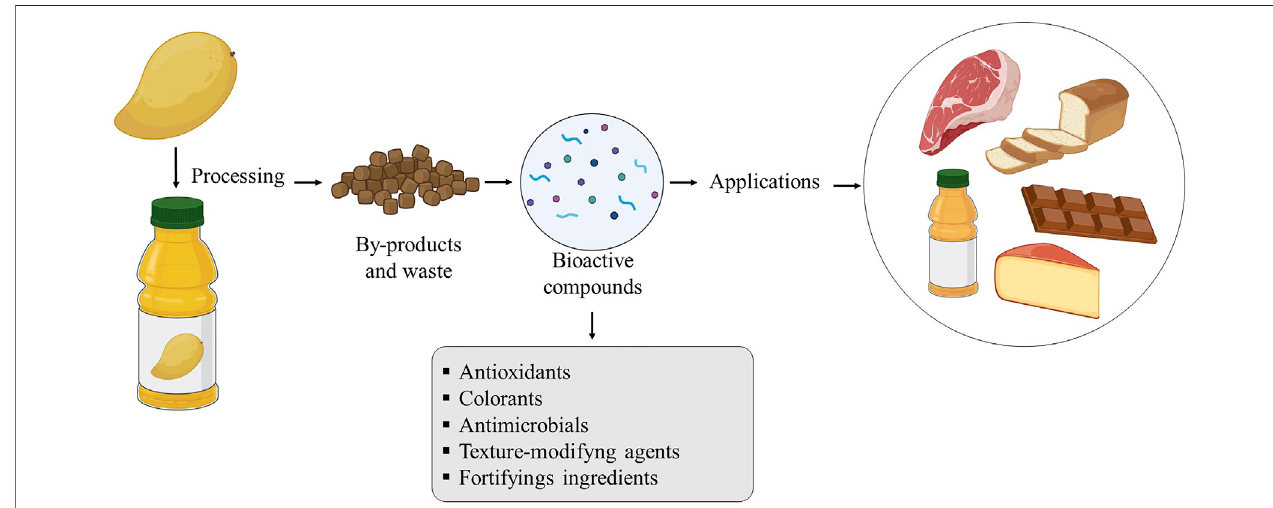
FIGURE 3 | Potential applications of bioactive compounds recovered from by-products.